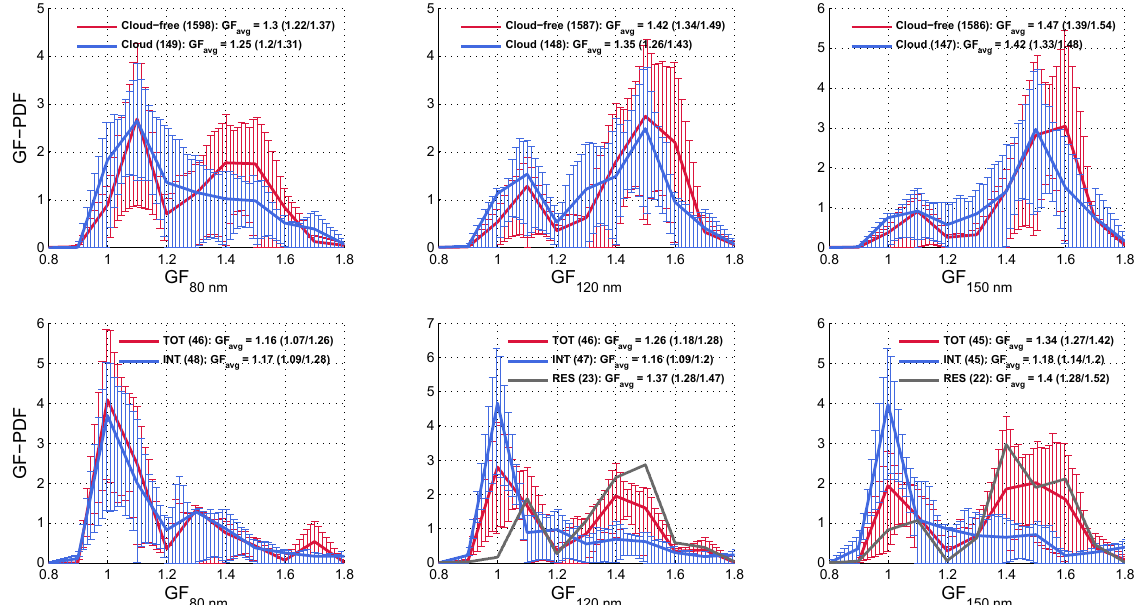
Figure 1. Top row: average hygroscopicity of total aerosol at 90% RH during cloudy (blue) and cloud-free (red) conditions (whole cam- paign). Bottom row: average in-cloud hygroscopicity of total (red), interstitial (blue) and residual aerosol (black) during the twin inlet period. The values shown in the parentheses represent the number of averaged observations and the 25th and 75th percentiles. In the graphs, the lower and upper quartiles are illustrated with whiskers.